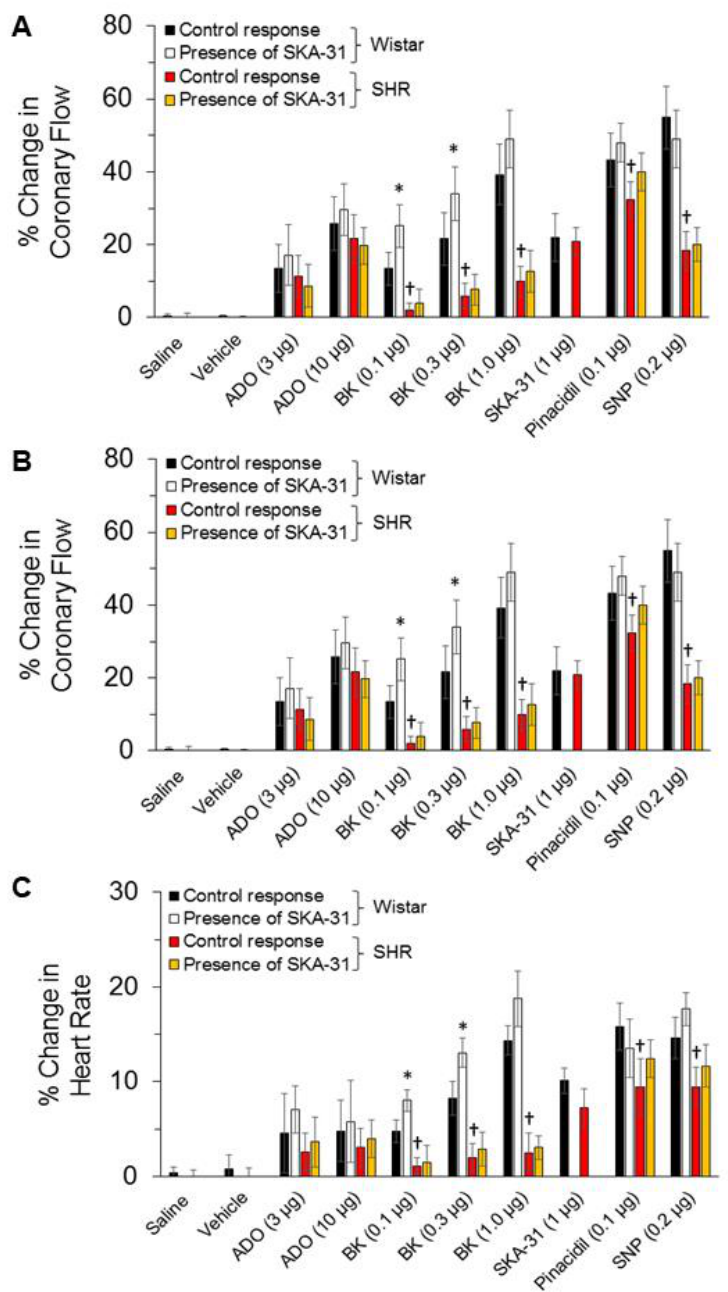
Figure 5. Quantification of drug-induced changes in coronary flow, left ventricular developed pressure, and heart rate in SHR and Wistar rat hearts. Histograms quantify the stimulus-induced changes in total coronary flow (panel ( A ), left ventricular (LV) developed pressure ( B ) and heart rate ( C ) following acute bolus administration of bradykinin (BK, 0.1, 0.3, and 1 µ g), adenosine (ADO, 0.3 and 10 µ g), SKA-31 (1 µ g), pinacidil (Pina, 0.1 µ g), and SNP (0.2 µ g) in spontaneously beating, Langendor ff -perfused male SHR and age-matched Wistar rat hearts. Values are expressed as a percentage increase in the indicated parameter relative to the baseline value recorded immediately prior to the administration of a given compound. Data are presented as mean ± SD and were analyzed by one-way ANOVA, followed by a Tukey’s post-hoc test. An asterisk (*) denotes a significant di ff erence in the magnitude of evoked response to an individual drug for a given strain; the † symbol indicates a statistically significant di ff erence in the magnitude of responses between the Wistar and SHR hearts; p <